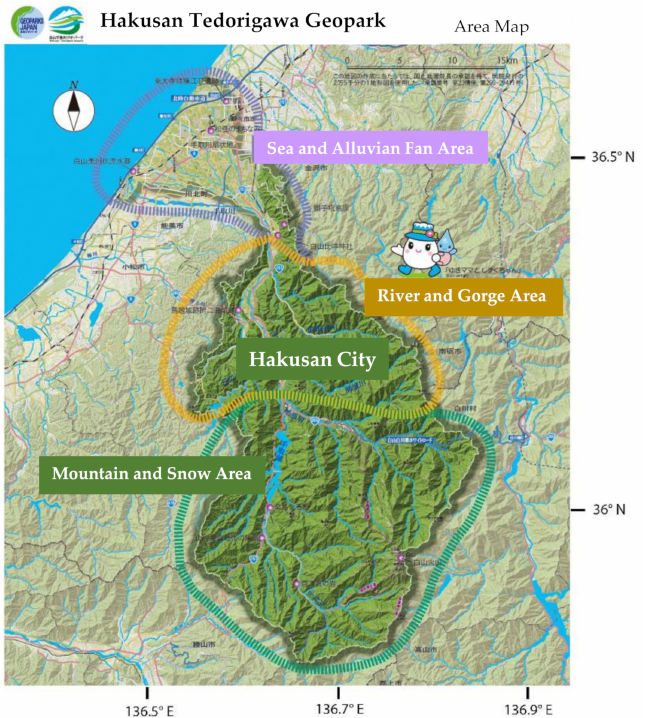
Figure 2. Entire territory of Hakusan City, designated as the National Mount Hakusan Tedori-river Geopark (Map provided by MHTGP Promotion